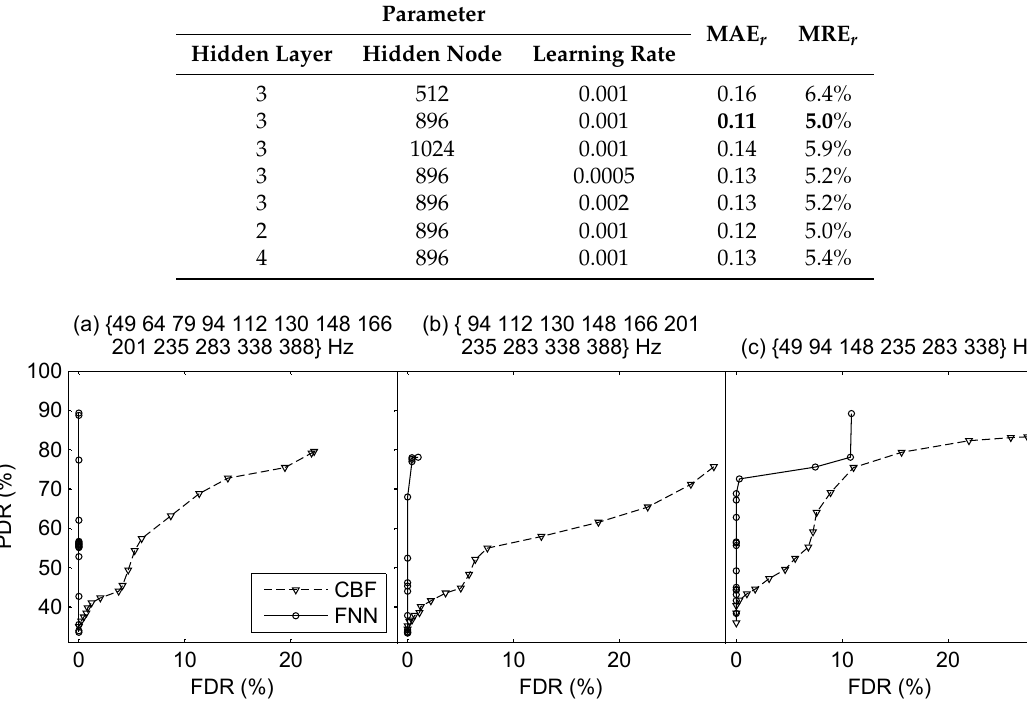
Figure 17. ROC curves of direction finding using different frequency bins in the three-source scenario using the real experimental